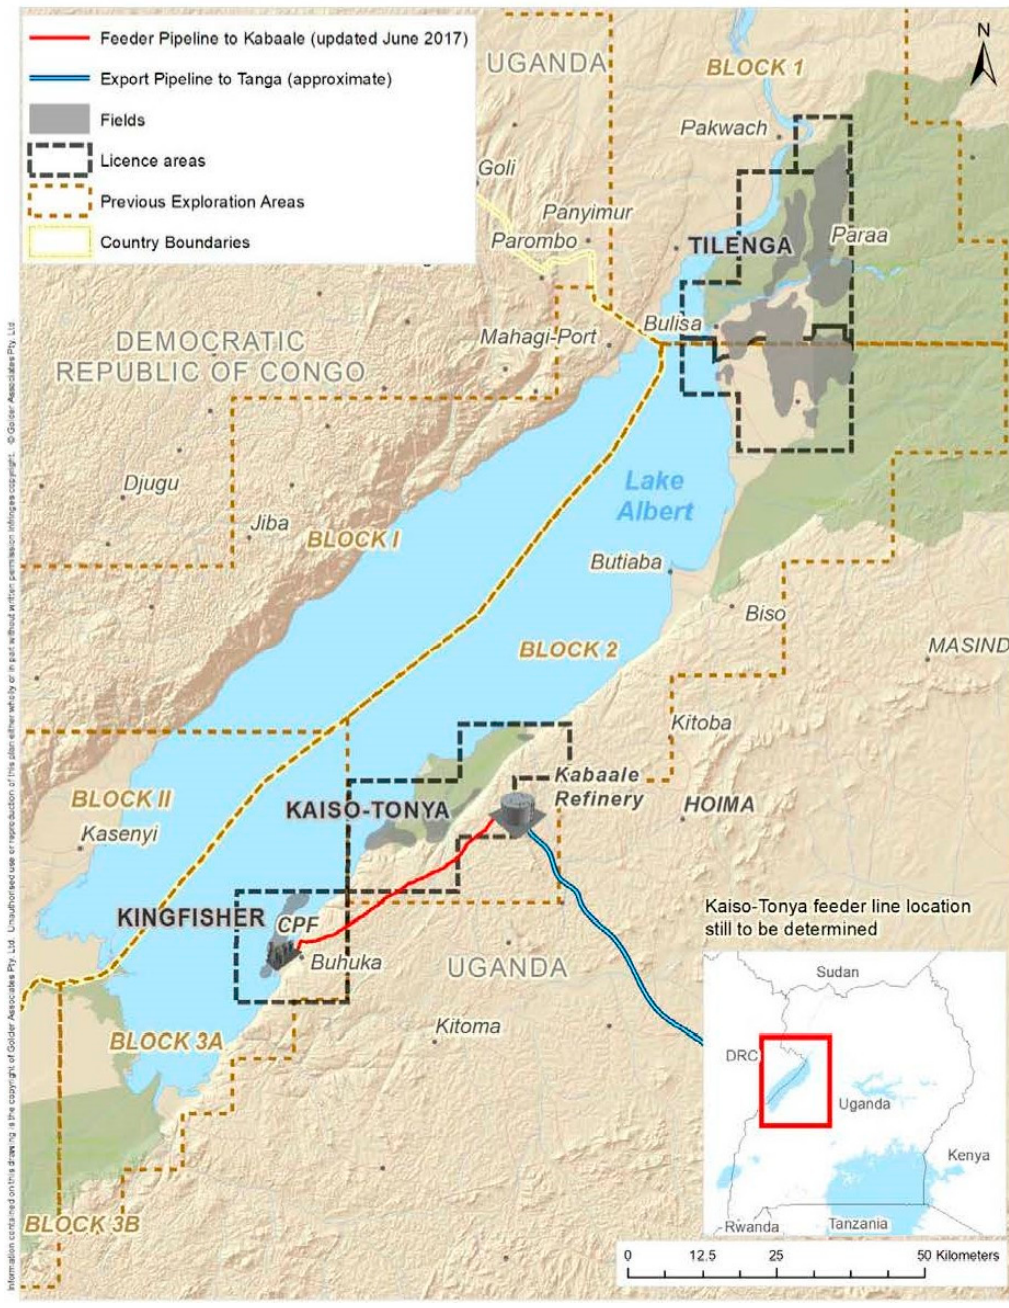
Figure 1. Map of Uganda showing the location of the projects (Source: Golder 2018 [44]).